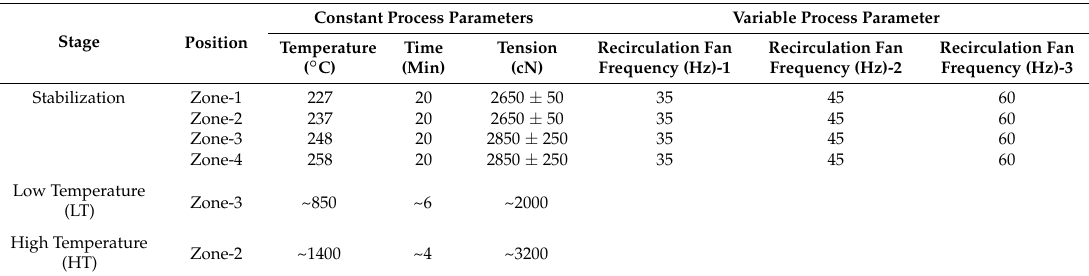
Figure 2. Schematic representation of the research production line at Carbon Nexus. Table 1. Process parameters used for sample preparation.